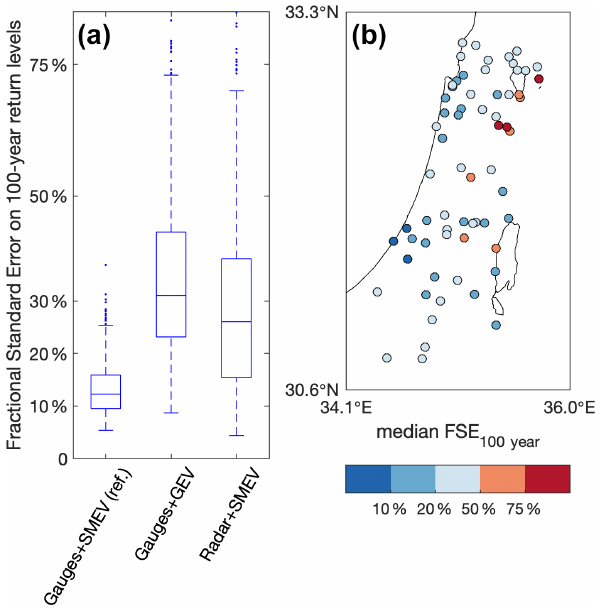
Figure 2. Validation of the radar-derived extreme return levels. (a) Fractional standard error (FSE) associated to the estimated 100- year return levels from (i) the reference, i.e. application of SMEV to the gauge full records (gauges + SMEV), (ii) traditional extreme value approaches on the gauge full records (gauges + GEV), and (iii) radar-derived return levels (radar + SMEV); all durations are considered. (b) Spatial distribution of the median (across all dura- tions) FSE for the 100-year return levels estimated using SMEV on the radar